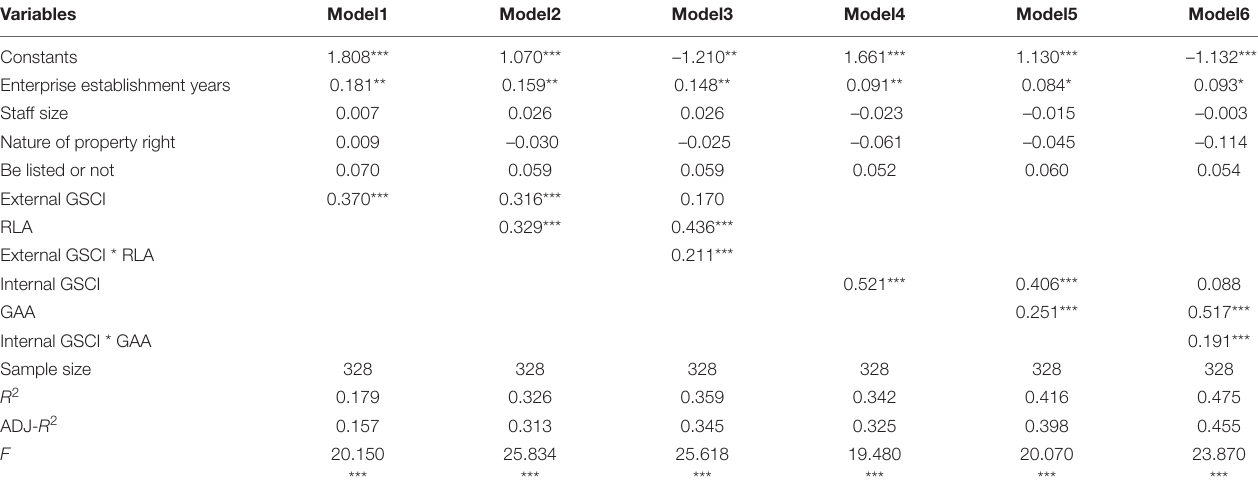
TABLE 6 | Results of the regression analysis (moderation